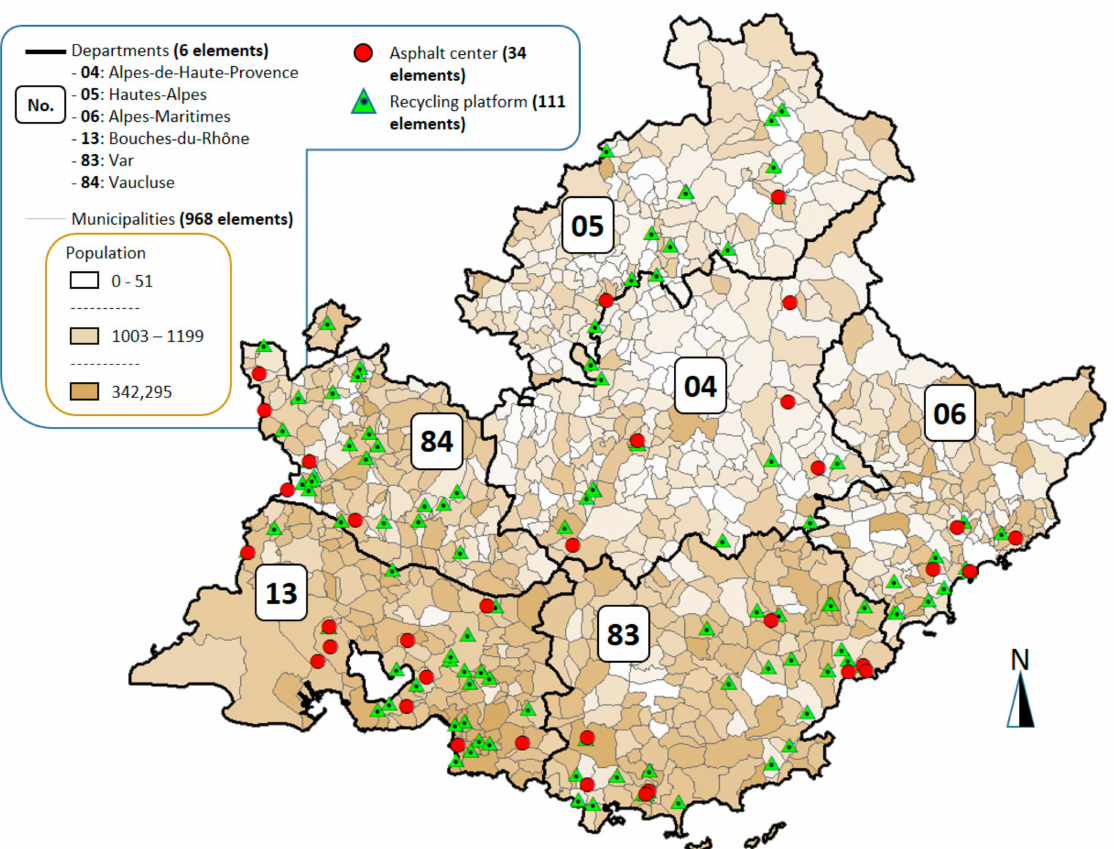
Figure 1. PACA region presented, with, in the form of a triangle, the 2015 locations of inert waste management sites (recycling platforms); in the form of a circle, asphalt plants; in the form of a polygon, the administration (Region, Department, Municipality); in the form of colours (from white to brown), population distribution per